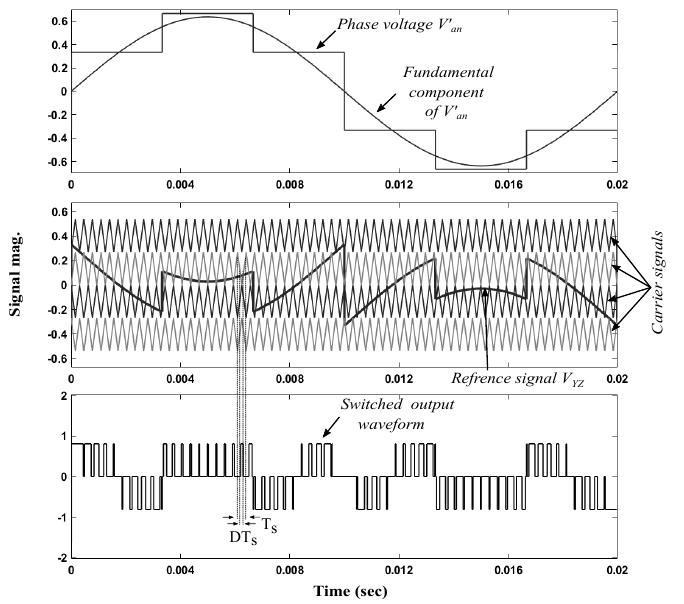
Figure 5. POD-PWM control